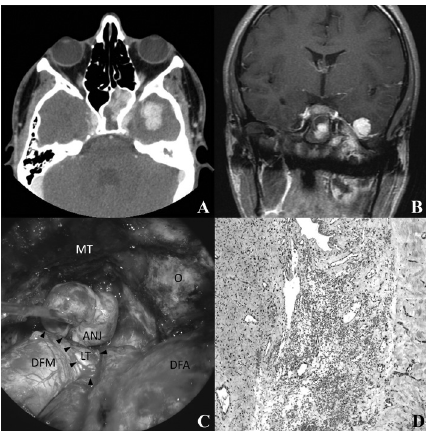
Figure 1. A) Axial CT showing the JNA with sphenoid sinus involvement and intradural extension, irrigated by ICA branches. B) T1-weighed coronal MRI with gadolinium showing the JNA extension to the middle fossa, in close contact with the temporal lobe. C) Microscopic view of the JNA dissection of the temporal lobe (LT) after opening the middle fossa dura mater (DFM). The arrows represent the open dura mater borders. MT. Temporal muscle; O. orbit; DFA. Anterior fossa dura mater. D) Micropho- tograph of the JNA fragment in the dura (left), in close contact with the dura mater (right) and tissue invasion areas (hematoxylin and eosin; 100